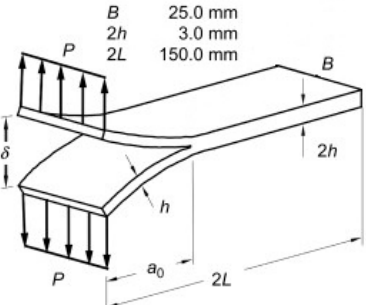
Figure 1. Specimen scheme for load application and dimensions.